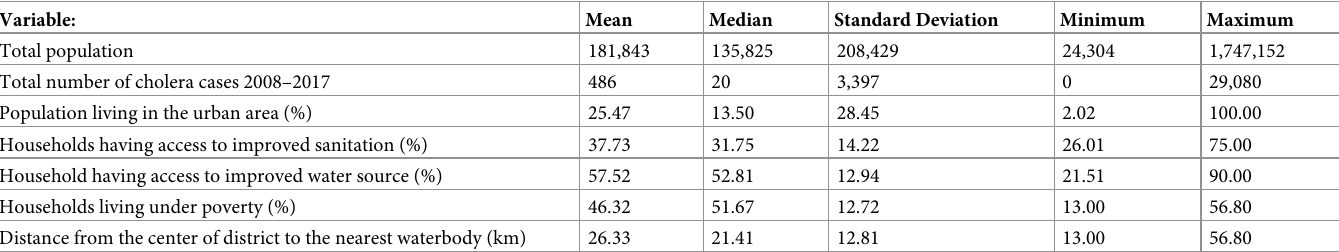
The results of our study identified 16 districts of Zambia as hotspots, but at varying levels of risk. Five of these districts had a relative risk > 5. A major hotspot identified was the city of Lusaka; 89% of the cases in this analysis were reported from Lusaka. Interestingly, only 3 of 33 wards in Lusaka district were identified as high risk areas. The sub-district (constituency) level data analysis of Lusaka found that only three of seven constituencies, with about 20% of the population (600,000 people), experienced high rates of cholera. This suggests that control efforts should focus in these constituencies. Lusaka has several densely populated peri-urban settlement areas with inadequate water and sanitation infrastructure which compromises sani- tation and hygiene, facilitating cholera transmission [3]. Lusaka has experienced prolonged rainfall that results in flooding, and this likely further increases cholera risk [2]. The city is also a center for an international cross-borders trading, with many people traveling between coun- tries which may also increase risk of transmission to the city. The hotspot areas outside Lusaka were near the borders with DRC, Tanzania, Mozambique, and Zimbabwe. Given the geographical distance between these border area hotspots, control Table 2. Descriptive statistics of the study variables (n = 72